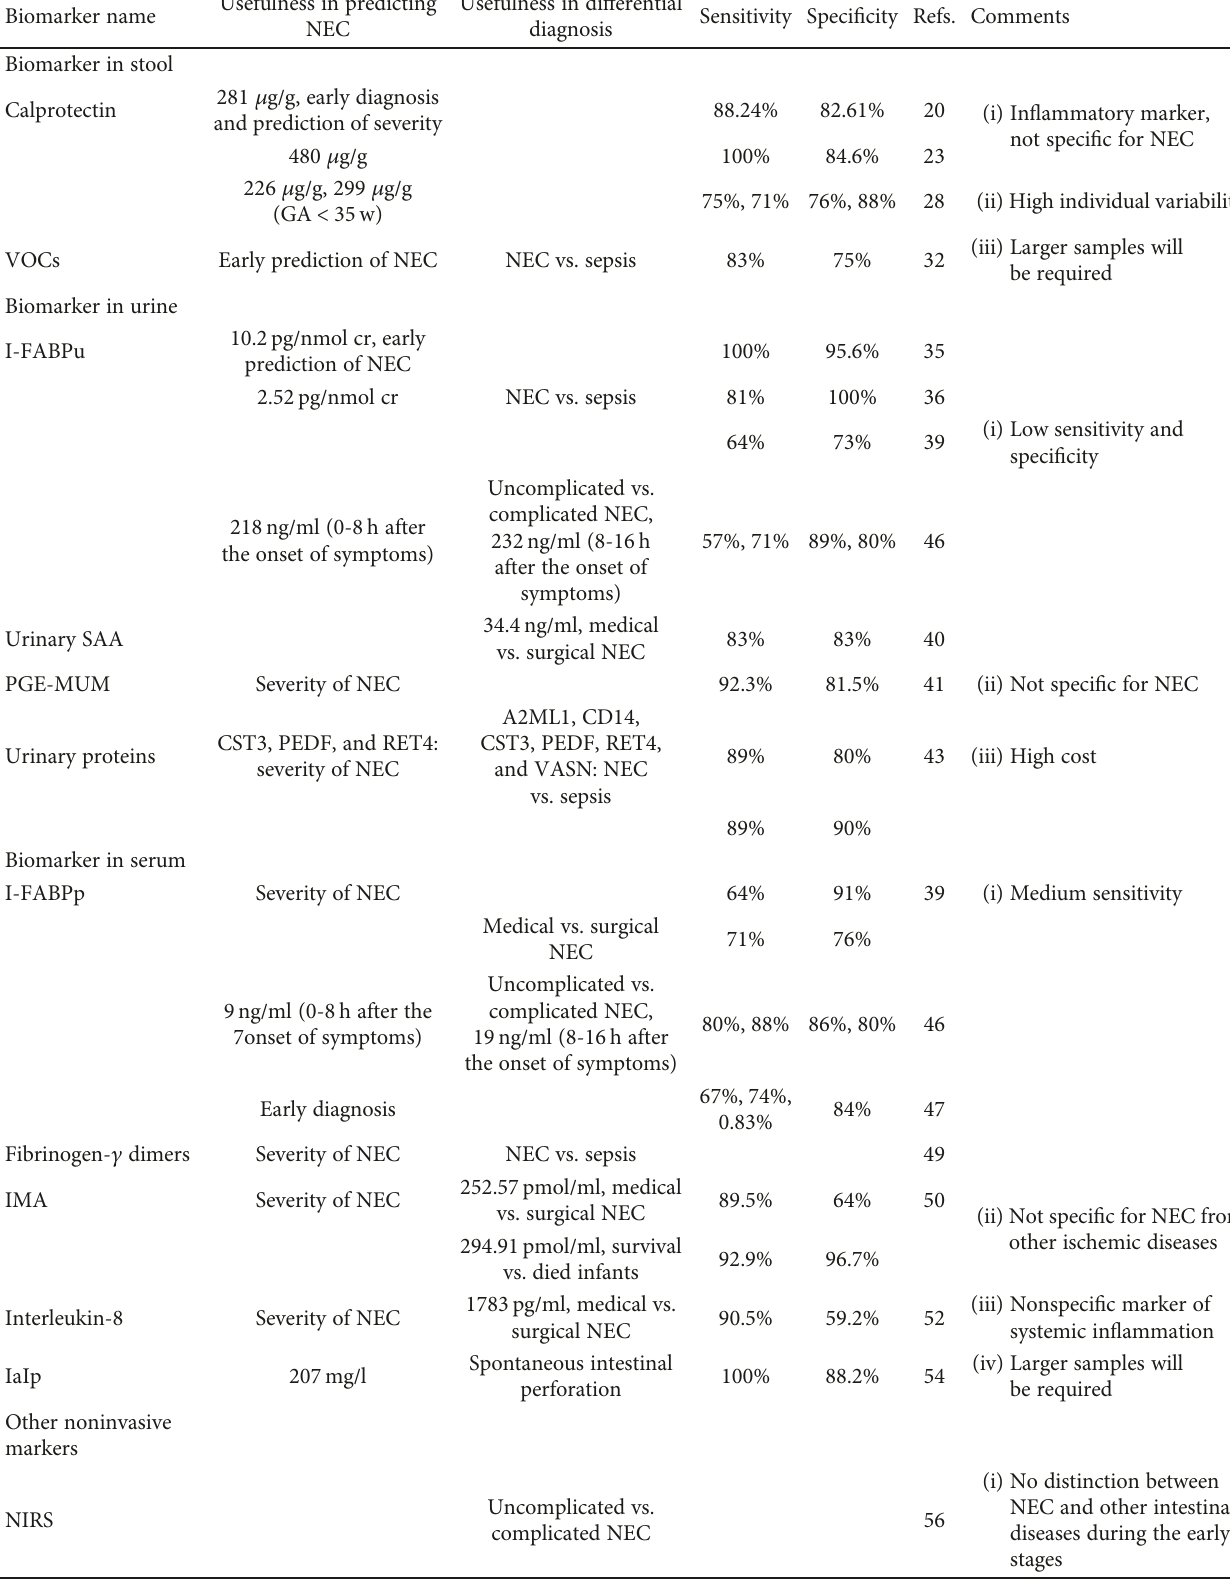
Table 1: Noninvasive biomarkers of